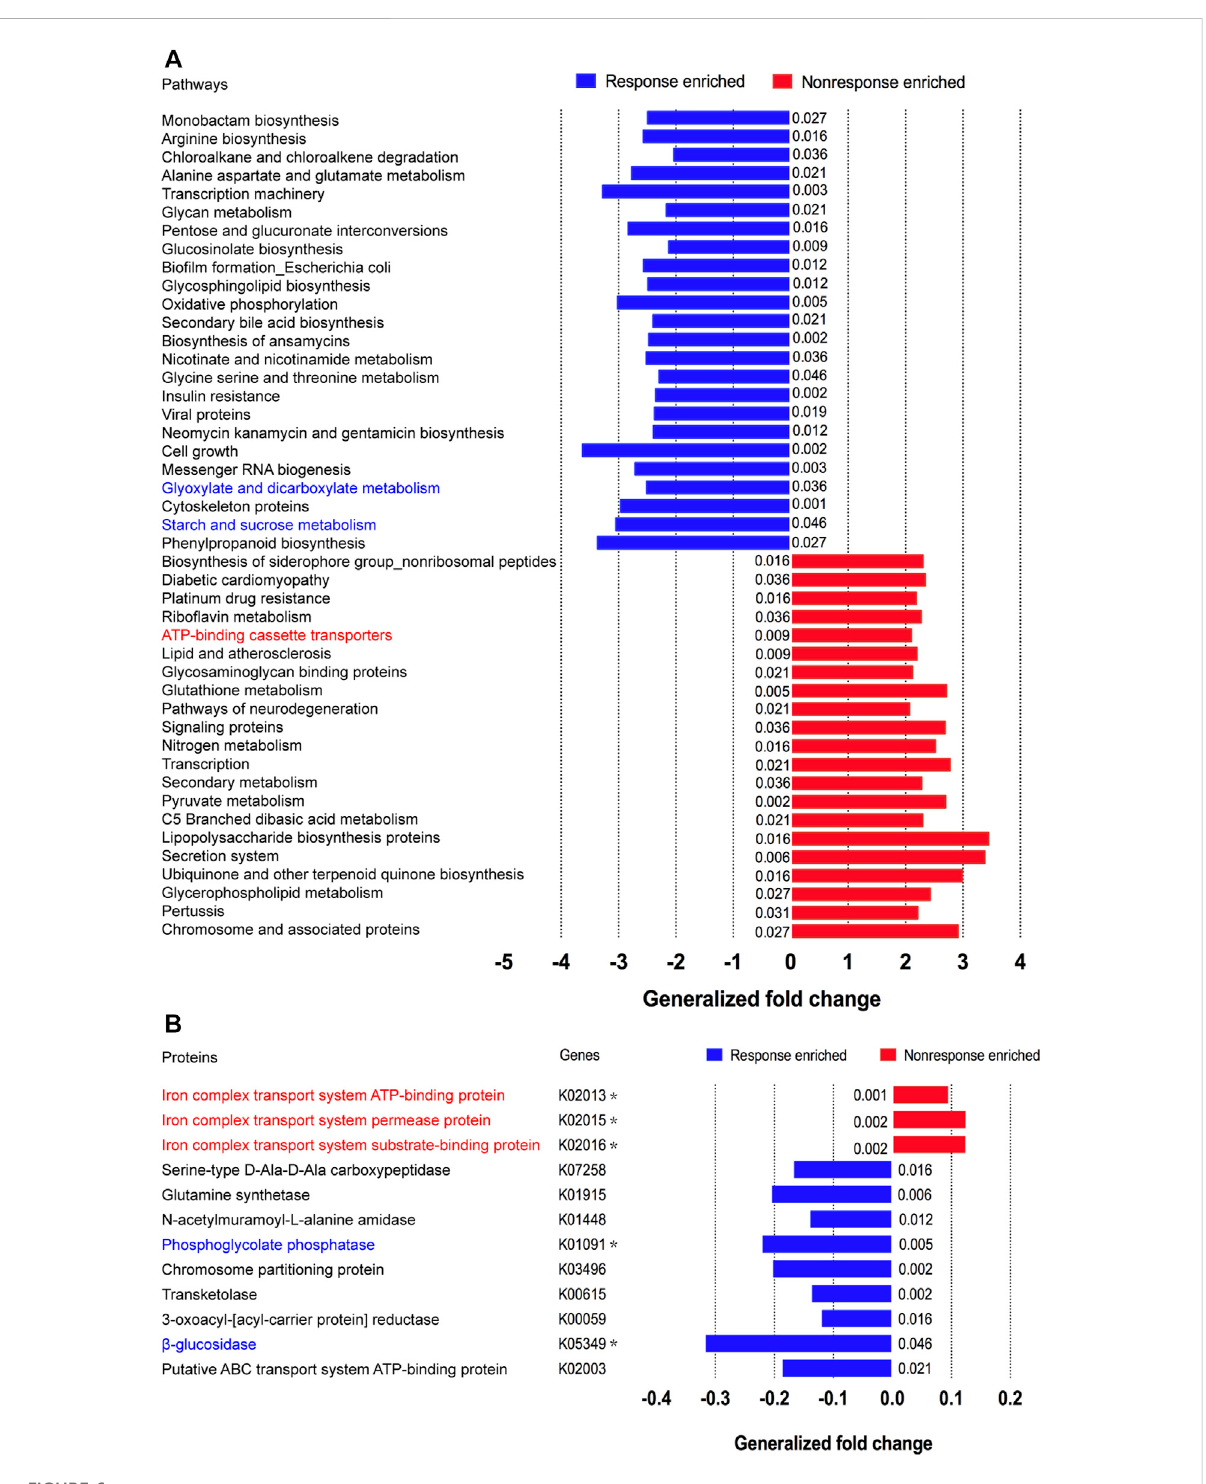
FIGURE 6 Microbial functional alterations in ADA response. The relative abundances of functional pathways (A) and bacterial genes (B) were compared between the nonresponsive adalimumab and responsive adalimumab samples. Differentially abundant pathways are highlighted in blue and red; p values were computed using a two-sided blocked Wilcoxon rank-sum test and the exact p values < 0.05 are presented beside the barplots. Generalized fold change (see the Materials and Methods section) is indicated by color gradients. The \generalized fold change > 0: enriched in the former; generalized fold change < 0: enriched in the